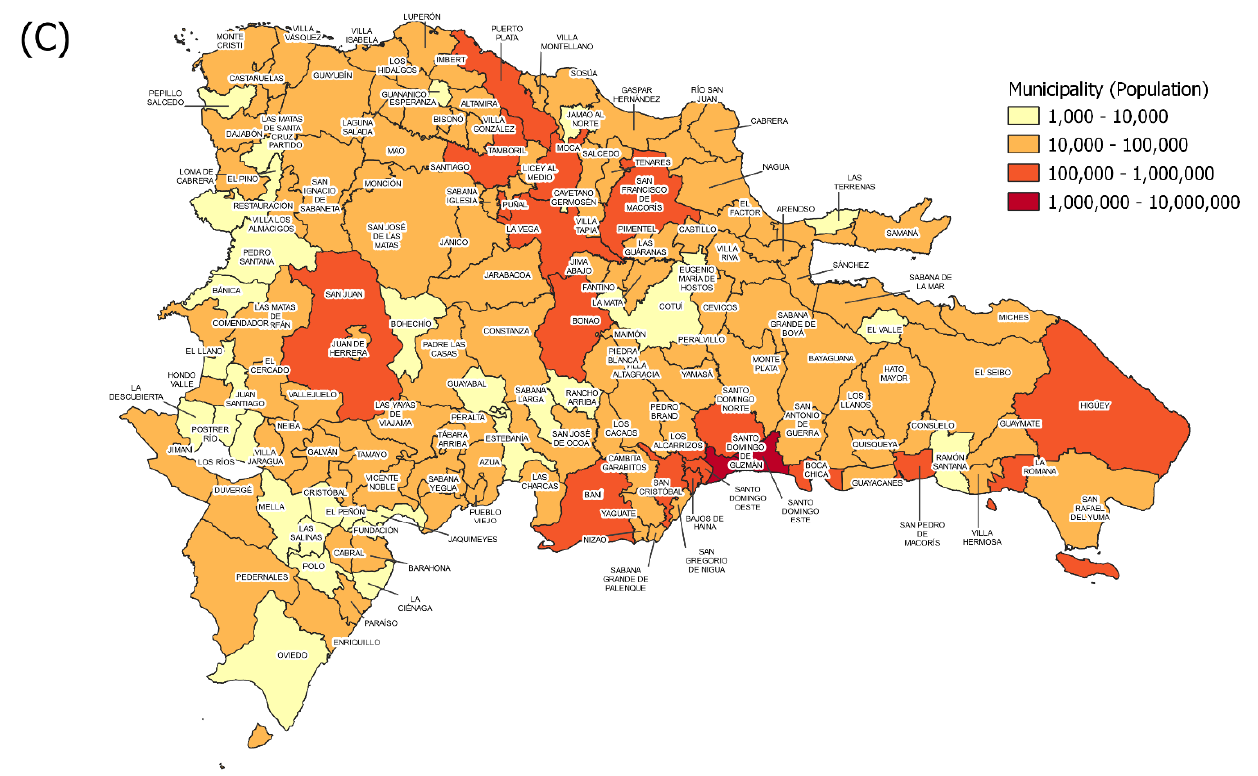
Figure 1. Mapping the Central and South American geographic area. ( A ) The location of the Dominican Republic on a continental scale. ( B ) Administrative municipal boundaries map of the Dominican Republic and ten most populous cities (not in order) [24]. ( C ) Administrative municipal boundaries map with 2016 population data, continuous colour scale from yellow (lowest) to red (highest). The shapefiles used for realisation of the Americas taken from the ‘ggplot2’ package and the Dominican Republic with administrative boundaries as they were in 2010, obtained from the Humanitarian Data Exchange [25,26].